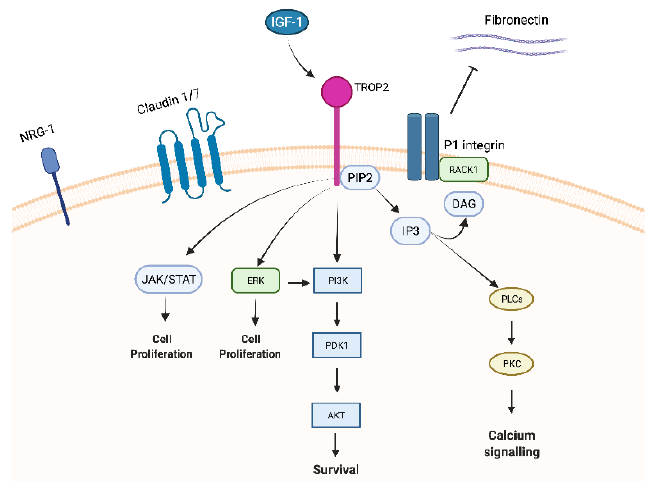
Figure 1. Trop-2 membrane-associated interacting partners and signalling